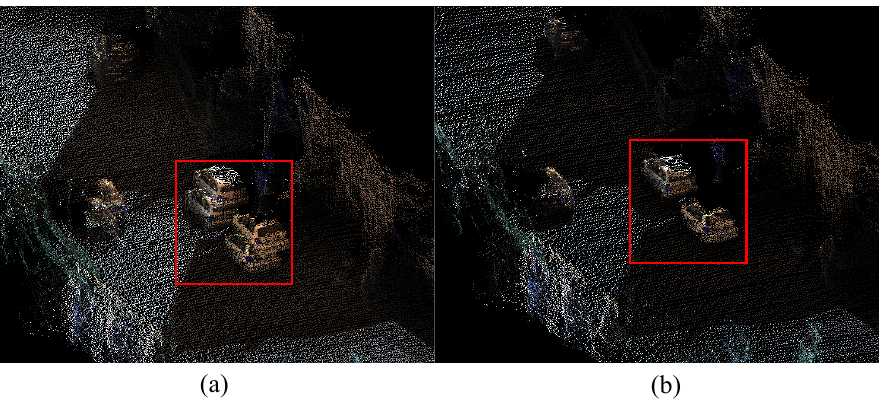
Figure 7. Reconstruction details of the revisited area. ( a ) Reconstruction details with a local map extraction based on time-series. ( b ) Reconstruction details of our method. The red frames show the performance differences between the two methods. Compared with ( b ), the cars of ( a ) are misaligned. The memory usage of the surfels throughout the runtime is shown in Figure 8. The or- ange curve is the result of our method without removing outliers. The black one is the result of our method with removing outliers. The blue one is the result of extracting local maps only based on time-series. There is almost no difference in the first 3200 frames because the car was moving to an unknown area in the scene. Between about 3200 and 4000 frames, the memory usage of our method stays almost unchanged because the car revisits the area between two red flags in Figure 6a, but the blue curve is still growing In addition, it can be seen that the memory usages of the black curve and orange curve are quite different. That